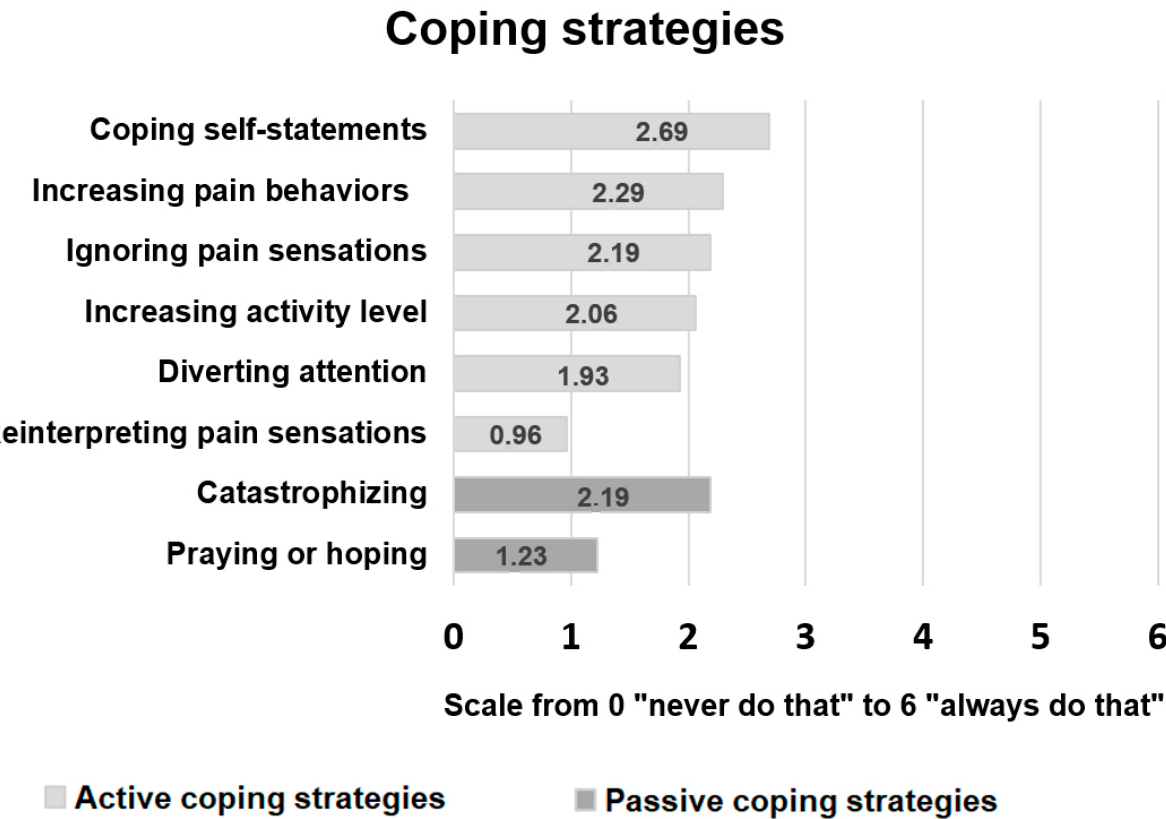
Figure 1. Use of pain coping strategies in ALS patients with pain, indicating the mean values of the CSQ subscale scores on a scale from 0 “never do that” to 6 “always do that”. The different pain coping strategies are grouped into active (highlighted in light grey) and passive coping strategies (highlighted in grey) and are arranged in descending order of the mean subscale scores within the respective category of coping style.